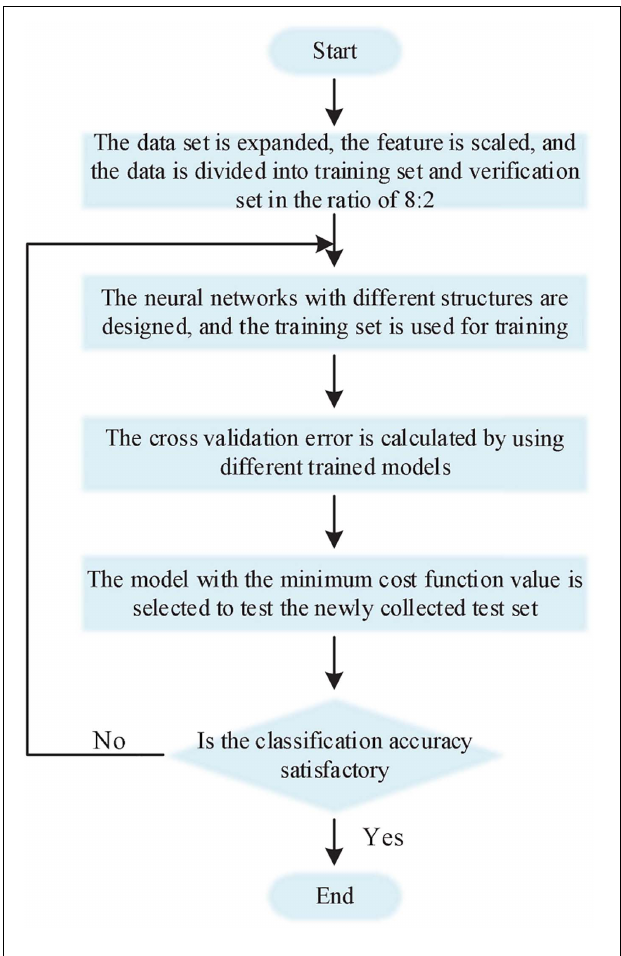
FIGURE 3 | Flow chart of BCI classifier design and